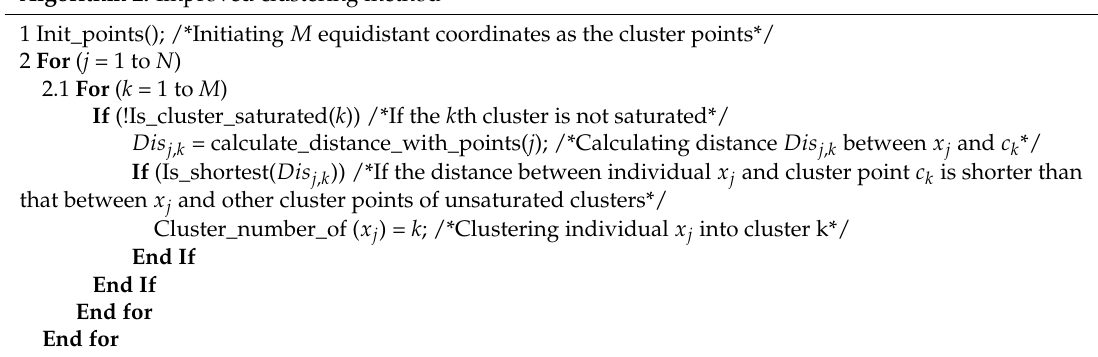
Algorithm 2. Improved clustering